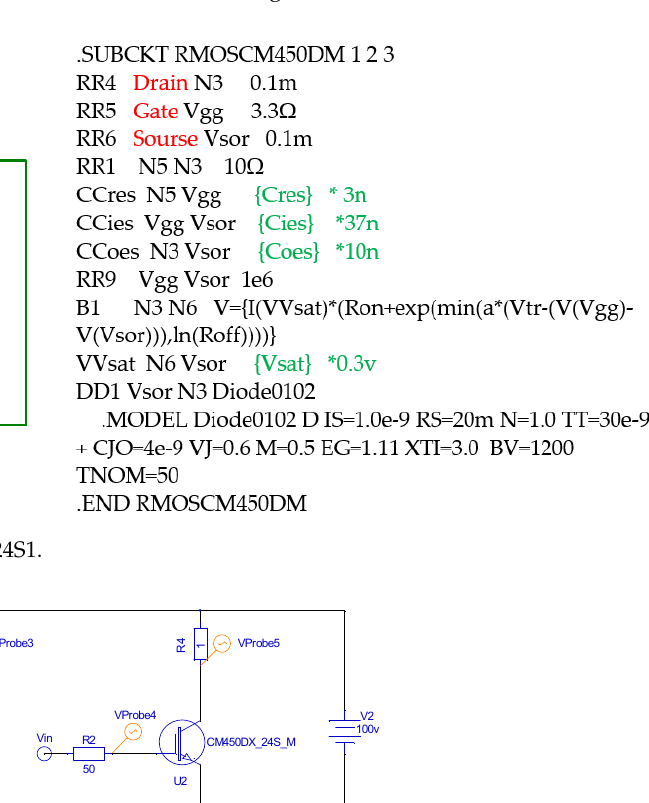
Figure 17. RMOS0101D with inductive-resistive load (Figure 15). We compared the accuracy model (Figure 5) for the Mitsubishi Electric CM450DX-24S1 module and the simple model for transistor RMOSCM450DM (Figures 18 and 19) with measurement data. Figure 18 shows the transistor diagram and SUBCKT file.